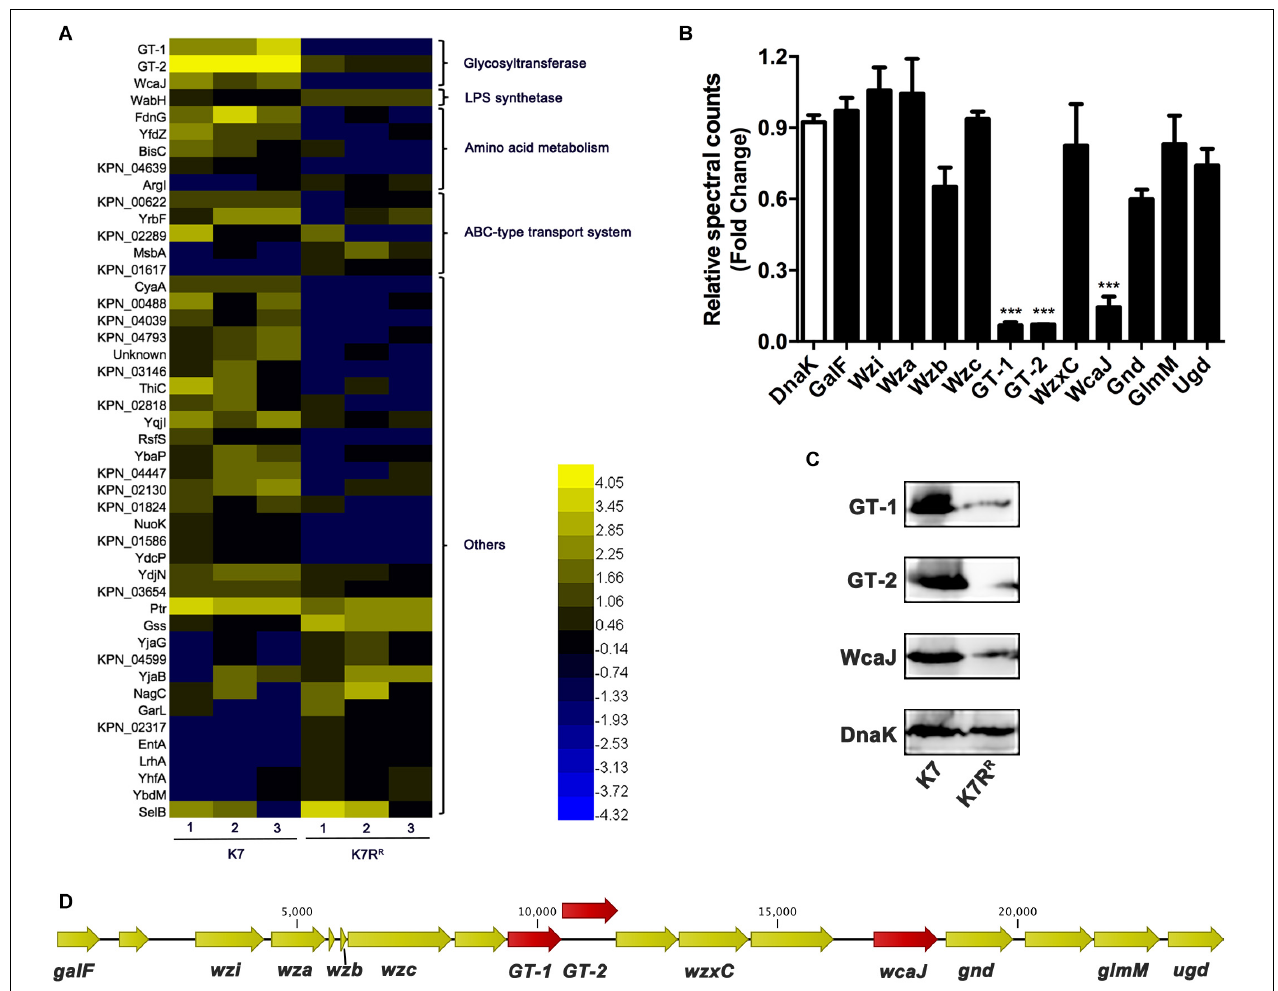
FIGURE 3 | The differentially expressed proteins between K. pneumoniae K7 and K7R R . (A) Heat-map analysis of differentially expressed proteins between K. pneumoniae K7 and K7R R . The heat-map was generated by Heml 1.0. Lanes 1–3 represent three biological replicates at each sampling time. Protein functional classification was performed by STRING, version 10.5. (B) Spectral count fold changes. The relative spectral counts of proteins encoded by cps gene cluster between K. pneumoniae K7 and K7R R were analyzed. DnaK served as a loading control. Relative spectral count fold changes = (spectral counts of K7R R )/(spectral counts of K7). ∗∗∗ represents significant differences at P < 0.001. Data represent the mean ± SEM of triplicate biological experiments at each sampling time. (C) Western blot analyses of GT-1, GT-2, and WcaJ. Expression levels of GT-1, GT-2, and WcaJ in K. pneumoniae K7 and K7R R were detected. Expression of DnaK was detected as a control. (D) Schematic of cps gene cluster of K. pneumoniae K7 indicated by arrows with different colors. The arrow represents the direction of